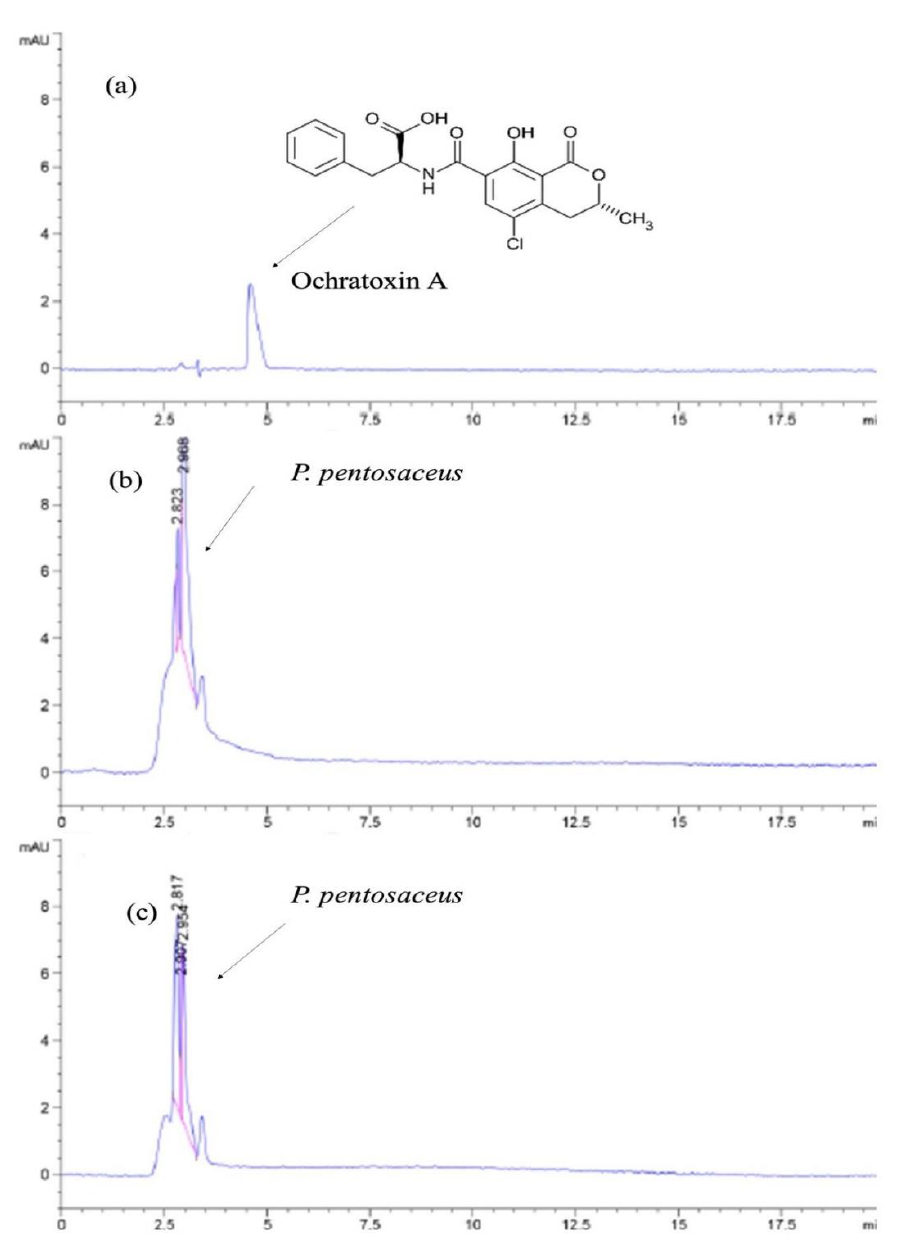
Figure 6. The OTA degradation ( a ) 0.8 ppm of OTA in MRS, ( b ) control ( Pediococcus pentosaceus in MRS without OTA) and ( c ) MRS after the incubation with P. pentosaceus and 0.8 ppm of OTA for 24 h.